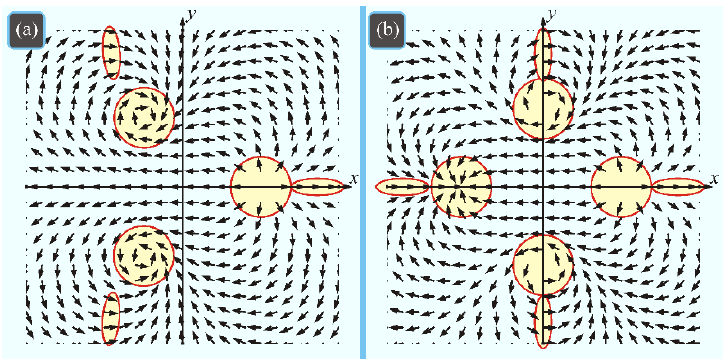
Figure 5. Jones vectors for field (19) with ( a ) three ( n = 3) and ( b ) four ( n = 4) polarization singularity points found at a distance of a = R /2 ( R is half-size of the computational domain) from the optical axis. Polarization singularity points are marked with circles, while ellipses highlight field regions where the polarizations vectors are directed to the right.